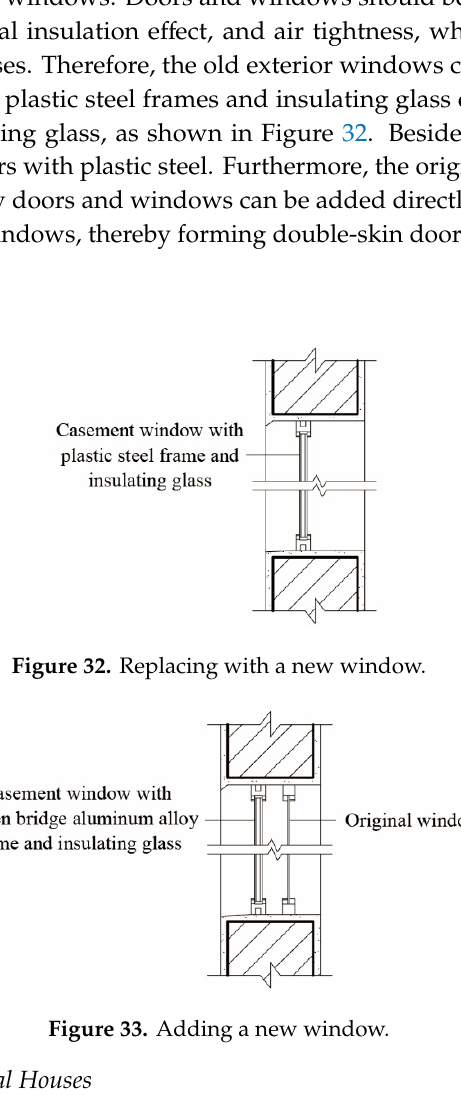
Figure 31. External thermal insulation.